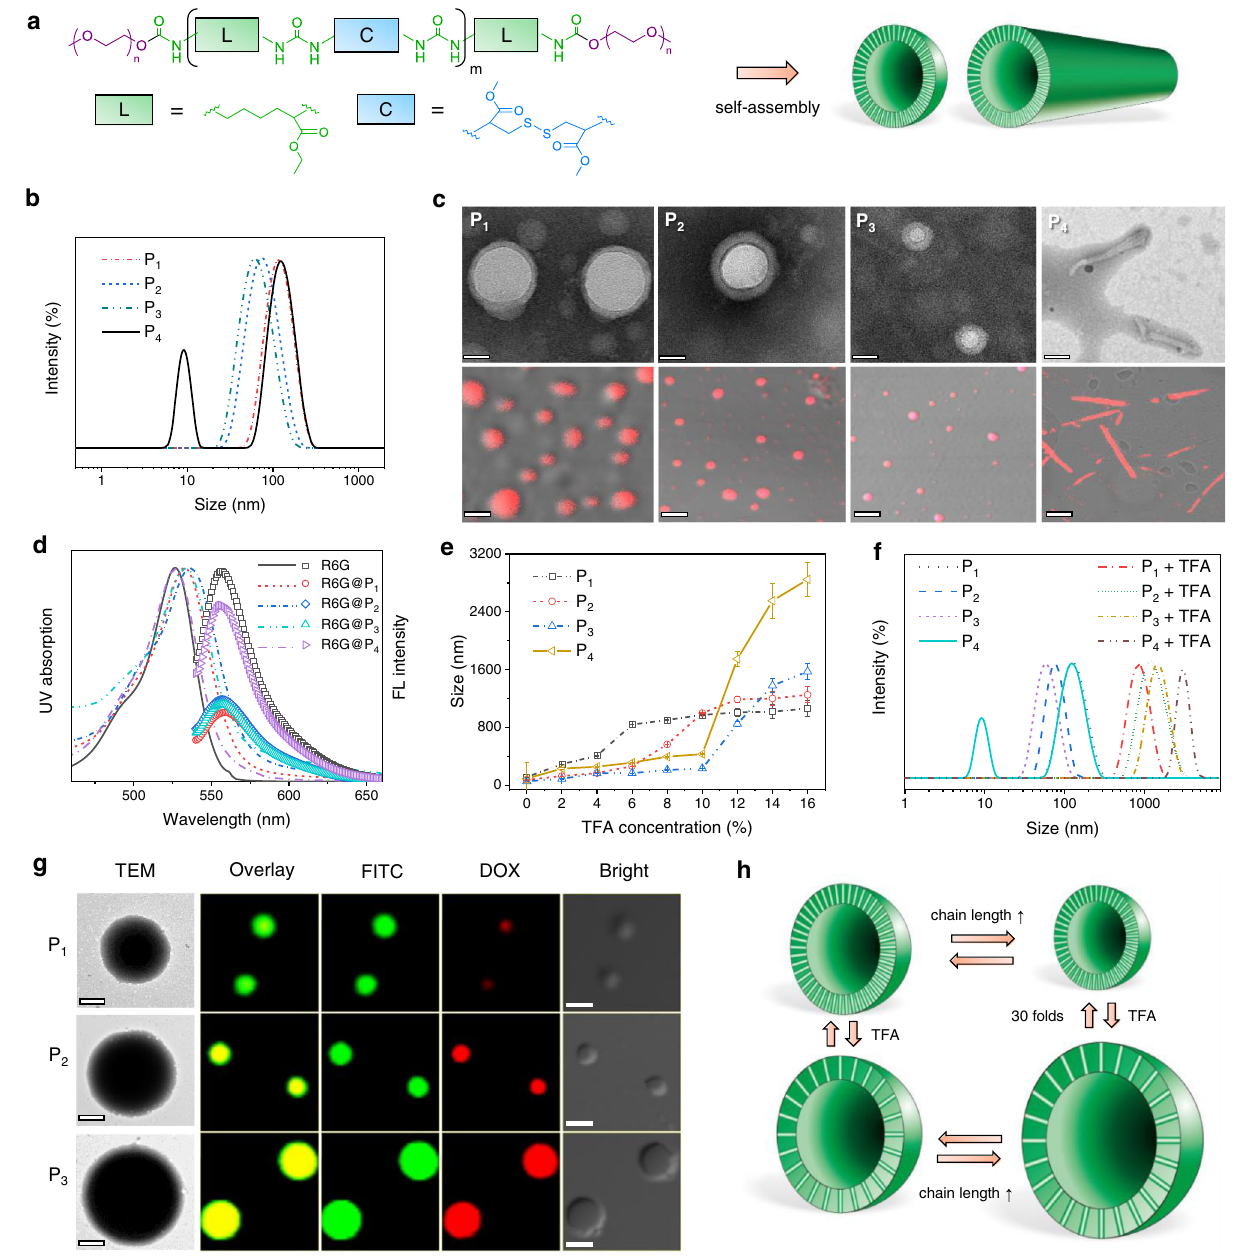
Fig. 1 | Self-assembly of PUs. a Schematic illustration of PUs and their assem- blies. b Size distribution pro fi les of PUs determined by dynamic light scattering (DLS). c TEM (upper) and CLSM (lower) images of PU assemblies. The scale bars in TEM images are 50nm and full TEM images are shown in Supplementary Fig. 10. For CLSM, the assemblies were encapsulated with DOX·HCl (red). The scale bars are 100nm. Experiments were repeated three times independently with similar results. d UV – vis spectra (left) and fl uorescence emission spectra (right, λ ex =526nm) of R6G dissolved in water and those encapsulated in PU assemblies (R6G@PUs) at the same concentration. e Size changes of PU